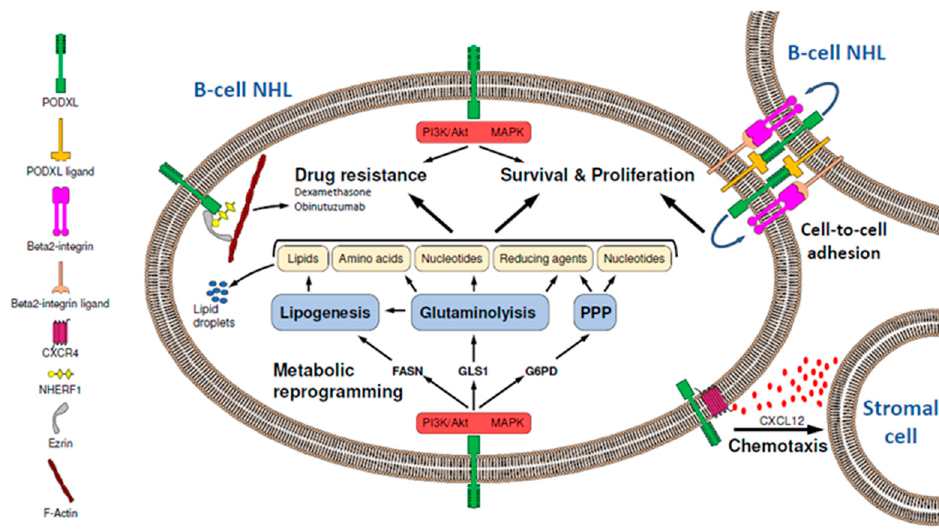
Figure 1. Schematic representation of the potential role of podocalyxin (PODXL) in mature B-cell non-Hodgkin lymphoma (B-NHL) progression. PODXL induces cell survival, proliferation, and drug resistance in mature B- NHL cells, likely through the activation of activated phosphatidylinositol 3-kinase (PI3K) / AKT and mitogen-activated protein kinase (MAPK) signaling pathways. Additionally, PODXL promotes glutaminolysis, lipogenesis, and pentose phosphate pathway via activation of glutaminase 1 (GLS1), fatty acid synthase (FASN), and glucose 6-phosphate dehydrogenase (G6PD), respectively, which would generate biomolecules and reducing agents necessary for tumor cell survival, proliferation, and drug resistance. This metabolic reprogramming may be mediated by PI3K / AKT and MAPK signaling pathways. The PODXL-induced B-NHL-resistance to obinutuzumab could be due to the capacity of PODXL to reorganize the actin cytoskeleton. In addition to this, PODXL favors cell-to-cell adhesion in B-NHL by a beta2-integrin-mediated process, which would lead to cell survival. PODXL also enhances chemotaxis of B-NHL cells towards C-X-C motif chemokine ligand 12 (CXCL12), which is released by stromal cells of distant sites and binds to C-X-C motif chemokine receptor 4 (CXCR4), a chemokine receptor that interacts with PODXL. NHERF1: Na + / H + -exchanger regulatory factor; PPP: pentose phosphate pathway.